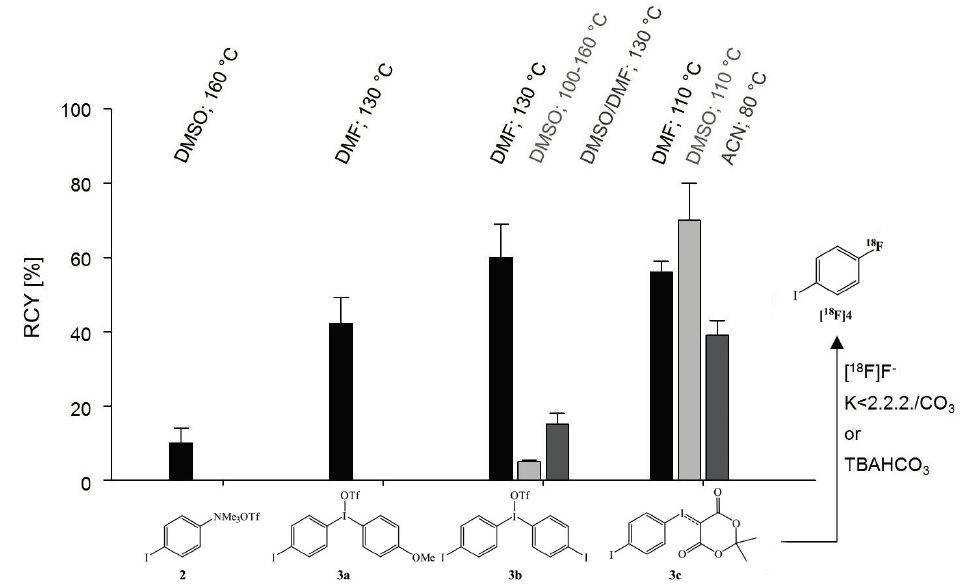
Figure 2. Radiosynthesis of 1-[ 18 F]fluoro-4-iodobenzene ([ 18 F] 4 ) by nucleophilic substitution on iodo(III)arenes under various reaction conditions ( n =